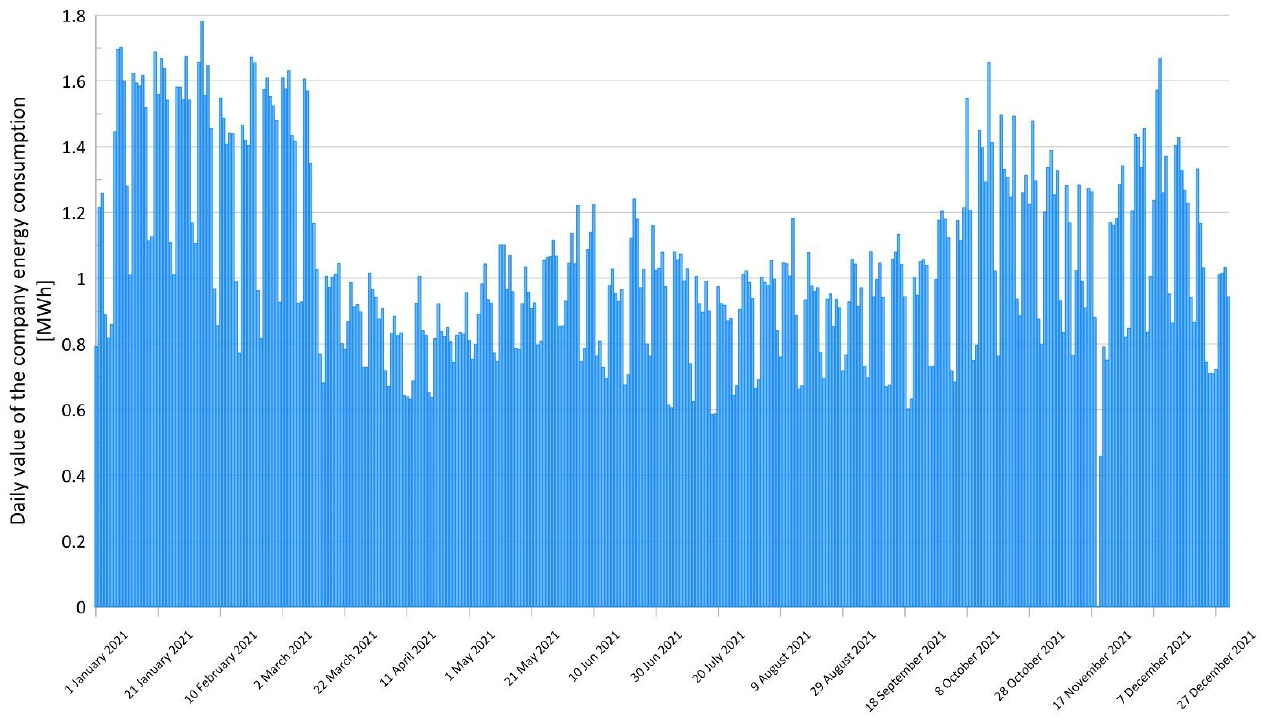
Figure A2. Daily values of the company energy consumption during the year 2021.